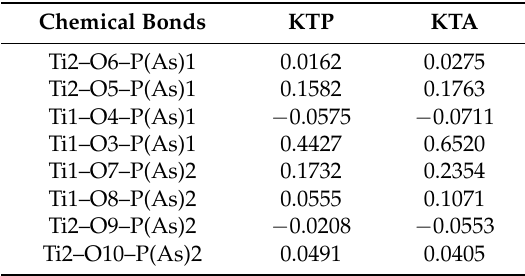
Table 2. Degree of deviation ( ∆ ) from the difference of the average Ti–O and P(As)–O interatomic distances in the structures of KTP and KTA single crystals.